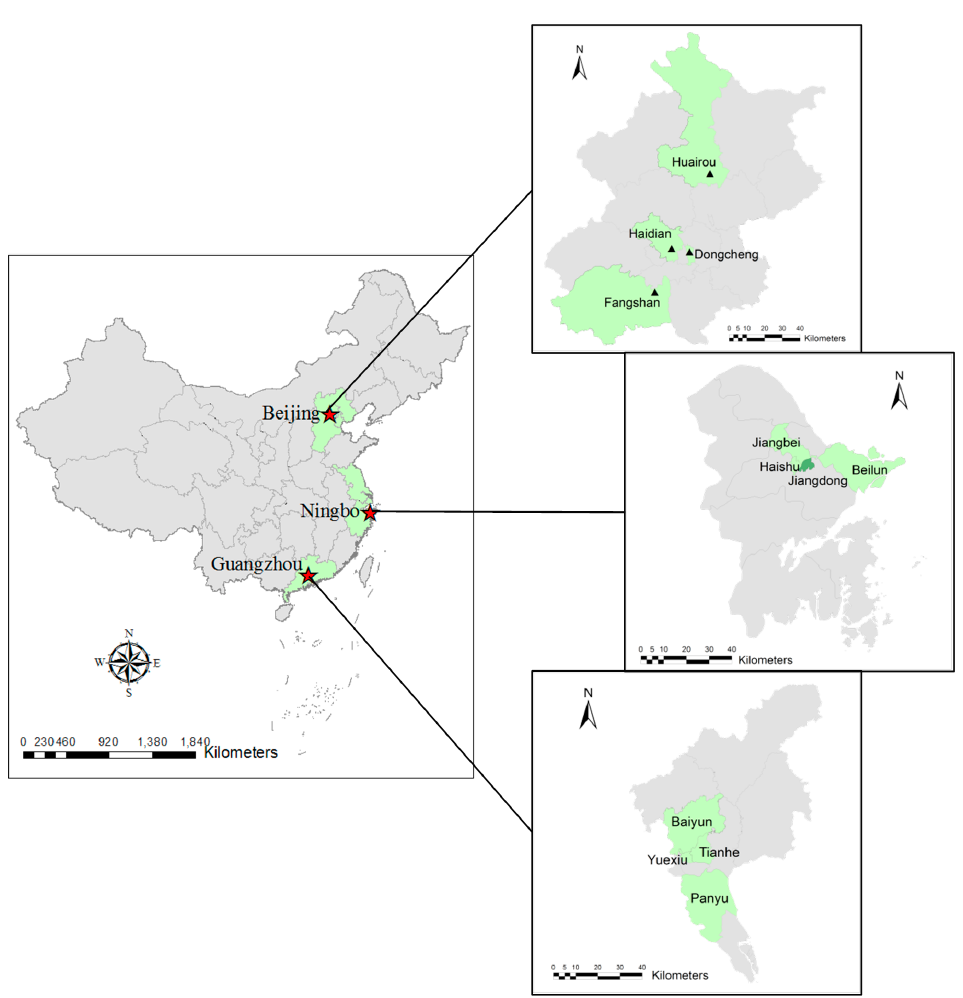
Figure 2. Study settings selected to conduct the field questionnaire survey.